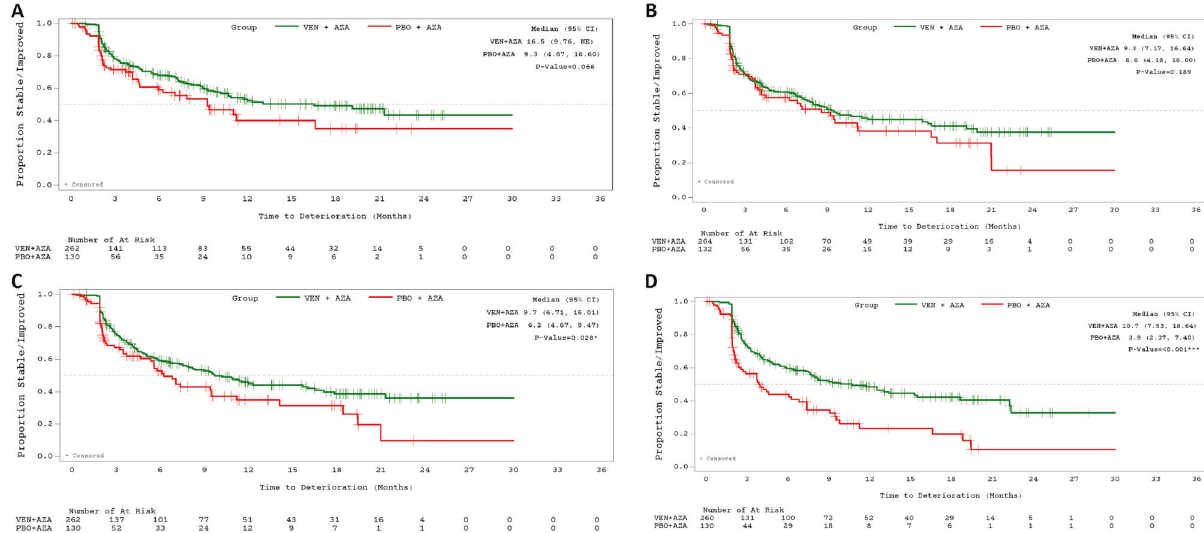
Fig. 1 Time to deterioration of PROs for Azacitidine based patients. Time to deterioration in EORTC GHS/QoL ( A ), PROMIS Fatigue ( B ), EORTC PF ( C ), and Health Status (EQ-5D-5L) VAS ( D ), VEN + AZA versus PBO + AZA. Time to deterioration thresholds for EORTC-QLQ-C30, EQ- 5D-5L VAS, and PROMIS Fatigue are ≥ 10, 7, or 5 points, respectively. Time to deterioration analyses were conducted for all patients in the full dataset with available data on ≥ 1 PRO measures from baseline to the given assessment ( N = VEN + AZA 262, 264, 262, and 260, and PBO + AZA 130, 132, 130, and 130 for EORTC GHS/QoL, fatigue, PF, and health status VAS, respectively). AZA azacitidine, CI con fi dence interval, EORTC QLQ-C30 European Organization for Research and Treatment of Cancer quality of life questionnaire, EQ-5D-5L EuroQoL 5-Dimension 5- Level, GHS global health status, NE not estimable, PBO placebo, PF physical functioning, PROMIS Patient-Reported Outcomes Measurement Information System, QoL quality of life, VAS visual analog scale, VEN